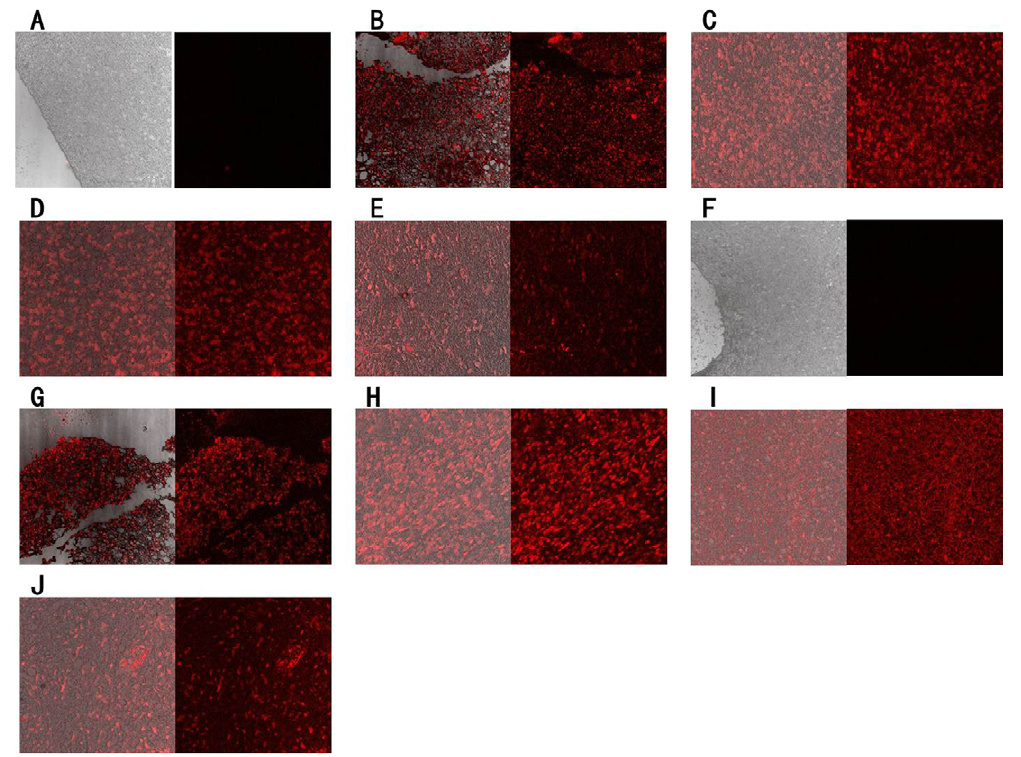
Figure 5. Using the selected aptamers to recognize FFPE normal or glioma tissue sections. FFPE tissue sections were incubated with cy5- labeled aptamers. A= Normal brain tissue with GBM128; B= Glioblastoma tissue with GBM128; C= Anaplastic oligodendroglima with GBM128; D= Oligoastrocytoma with GBM128; E= Pilocytic astrocytoma with GBM128; F= Normal brain tissue with GBM131; G= Glioblastoma tissue with GBM131; H= Anaplastic oligodendroglima with GBM131; I= Oligoastrocytoma with GBM131; J= Pilocytic astrocytoma with GBM131. The final concentration of Cy5-labeled aptamers was 250 nM.